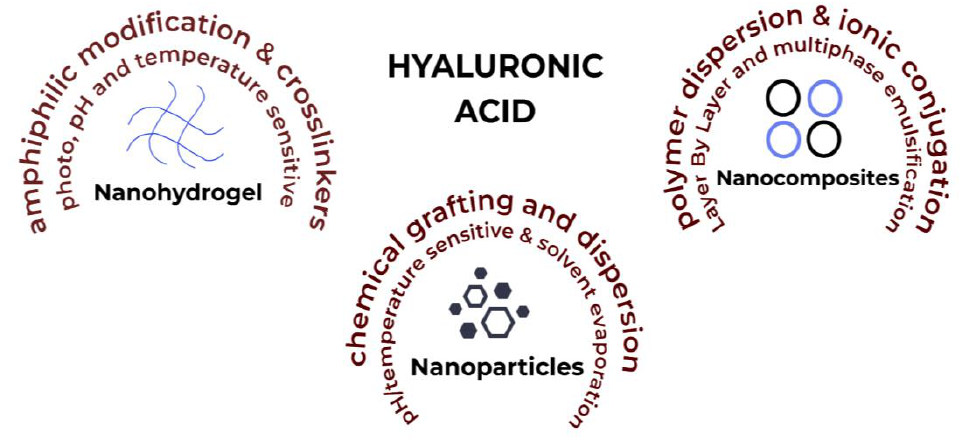
Figure 3. HA-based nanosystems with factors affecting their synthesis and